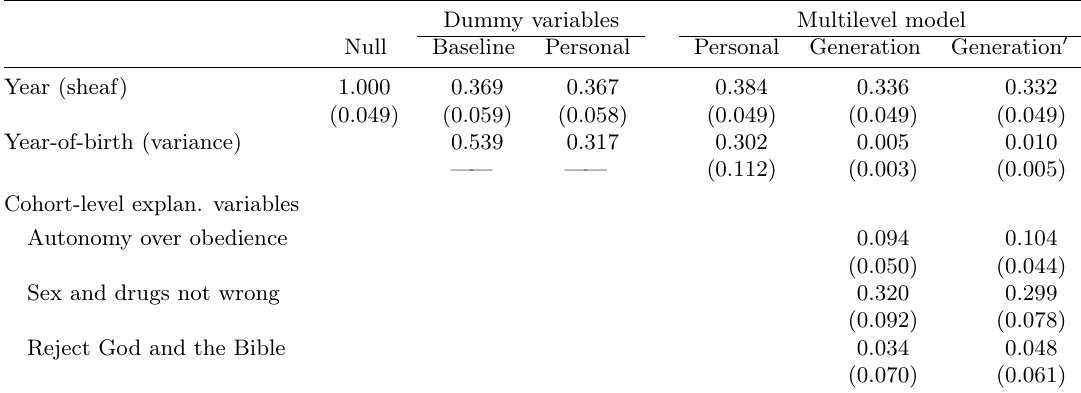
Table 2: Coefficients and Standard Errors for Year (sheaf) and Cohort-level Explanatory Variables Plus the Variances of Year-of-birth Coefficients from Selected Models of Religious Preference by Method of Estimating Year-of-birth Effects: Persons 25 Years Old and Over, United States, 1973-2012.